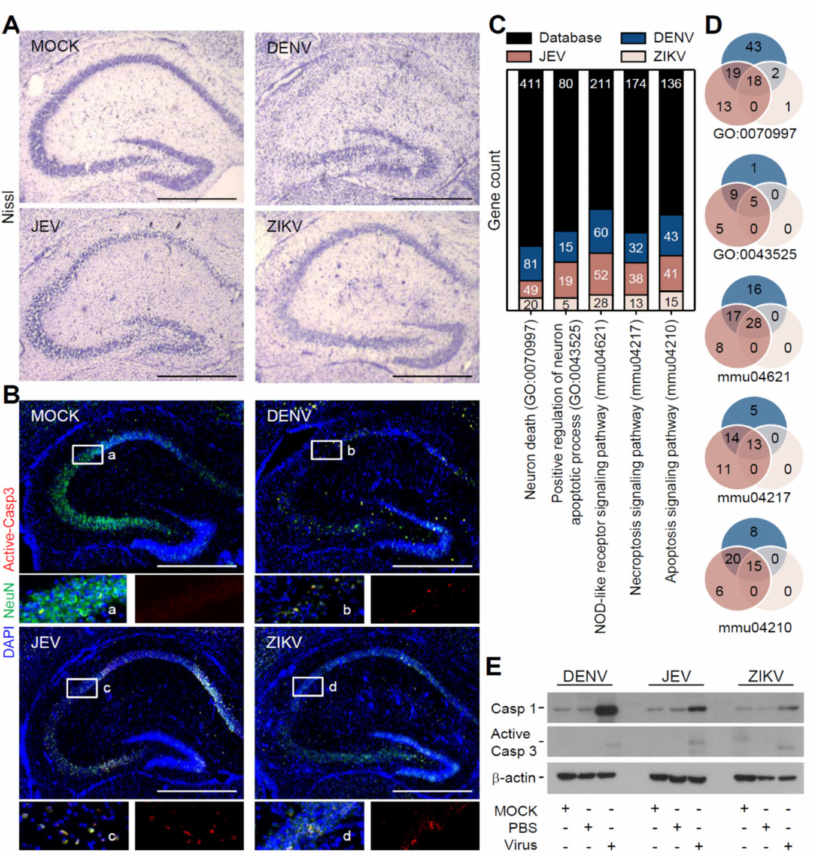
Figure 2. Flavivirus infection caused neuropathy in the hippocampus. Following DENV, JEV, and ZIKV infection in neonatal ICR mice for 5 days, representative images revealed ( A ) Nissl staining and ( B ) fluorescent staining of NeuN (green) plus active caspase (Casp)-3 (red) expression to show neuronal destruction in the hippocampus. DAPI (blue) was stained for nuclei. ( C ) Gene ontology enrichment analysis showed the changed gene expression involving cell death-related